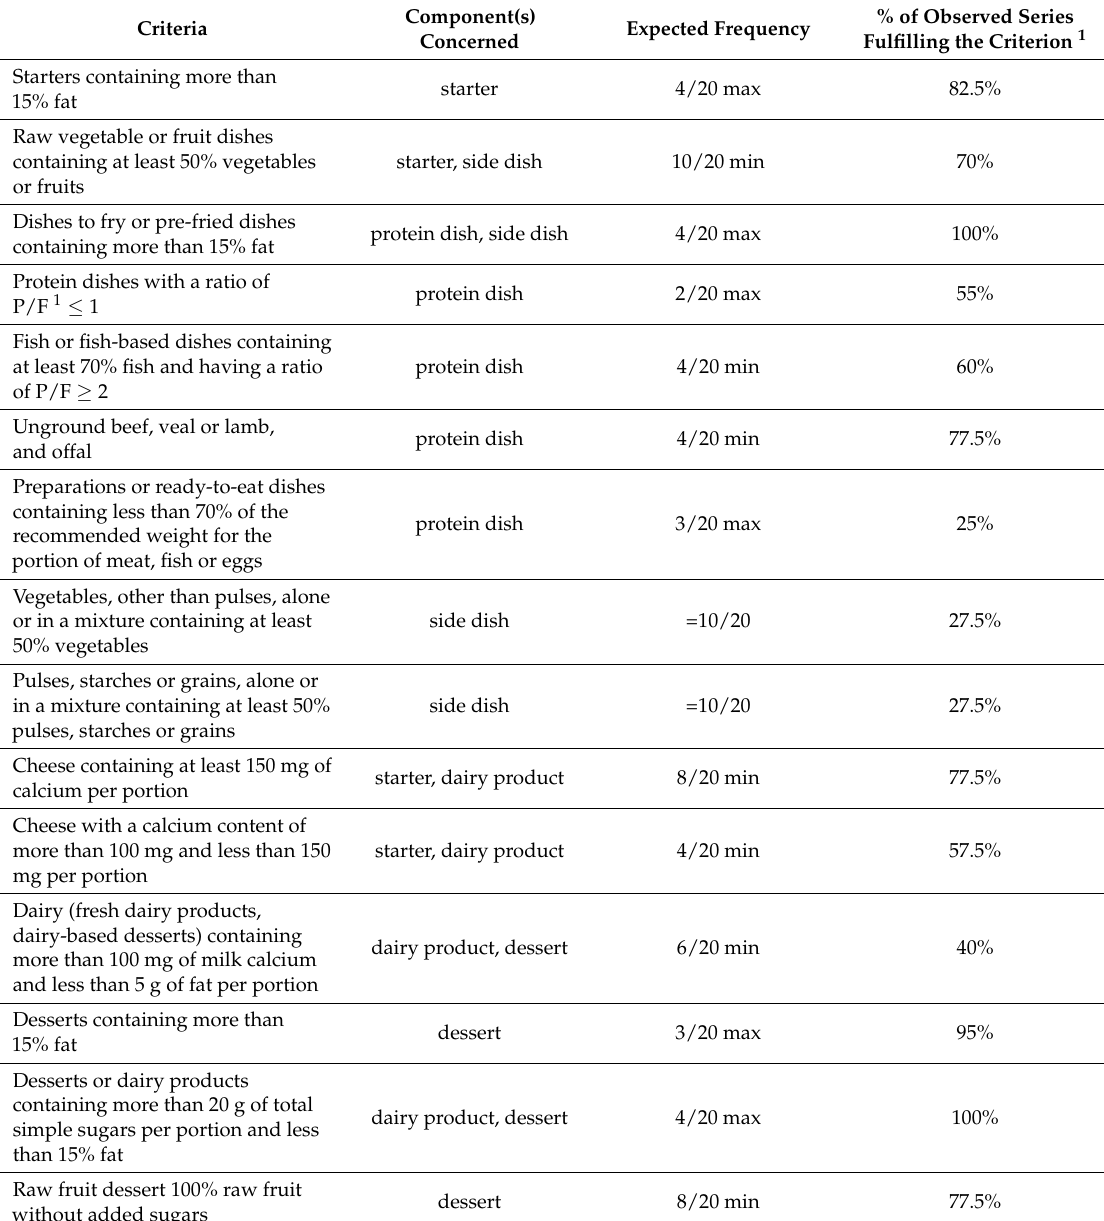
Table 1. The 15 frequency criteria for school meal service in France [10,13] and the percentage of series fulfilling each criterion among the 40 observed series of 20